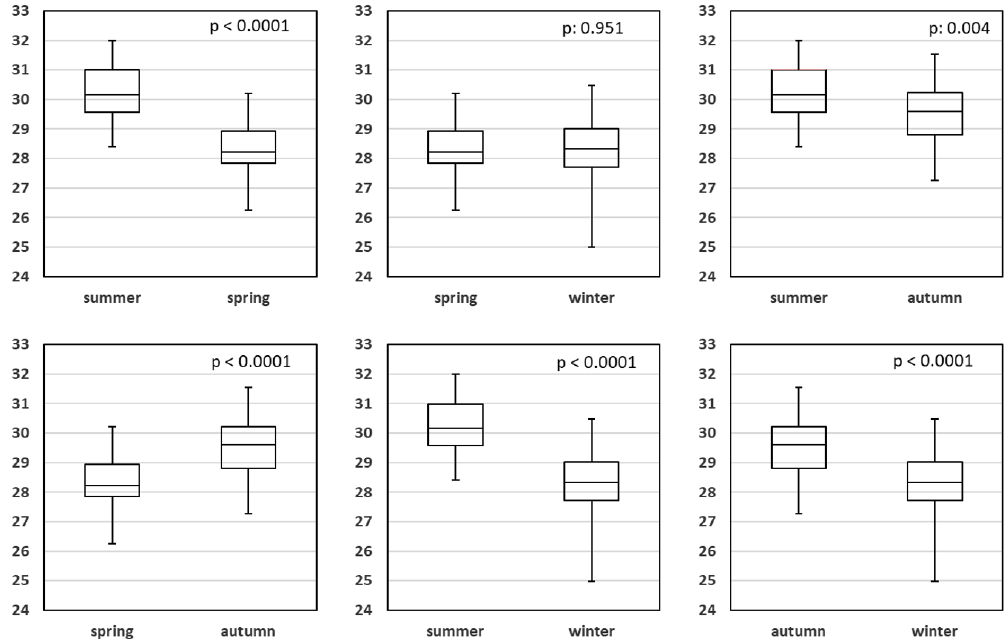
Figure 13. All-season comparison of salinity values for the entire time